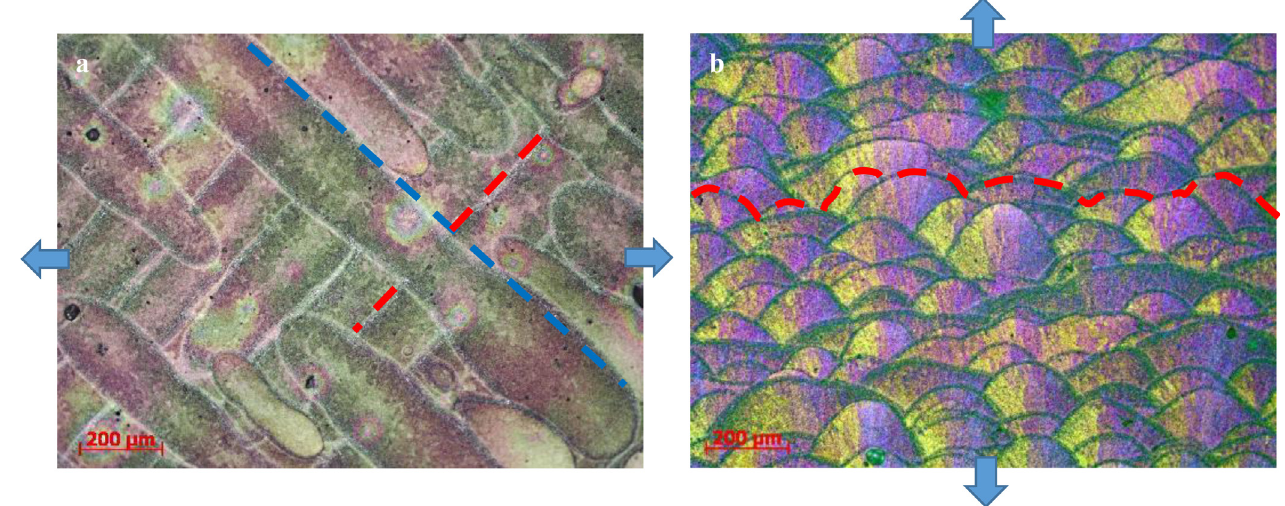
Fig. 11. Tensile stress on a tensile test piece. (a) XY plane (cid:1) (b) Z direction.